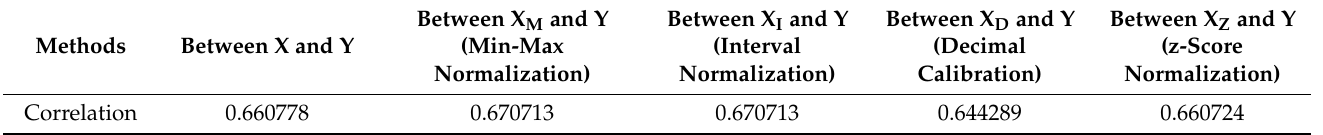
Table 1. Correlation by four normalization